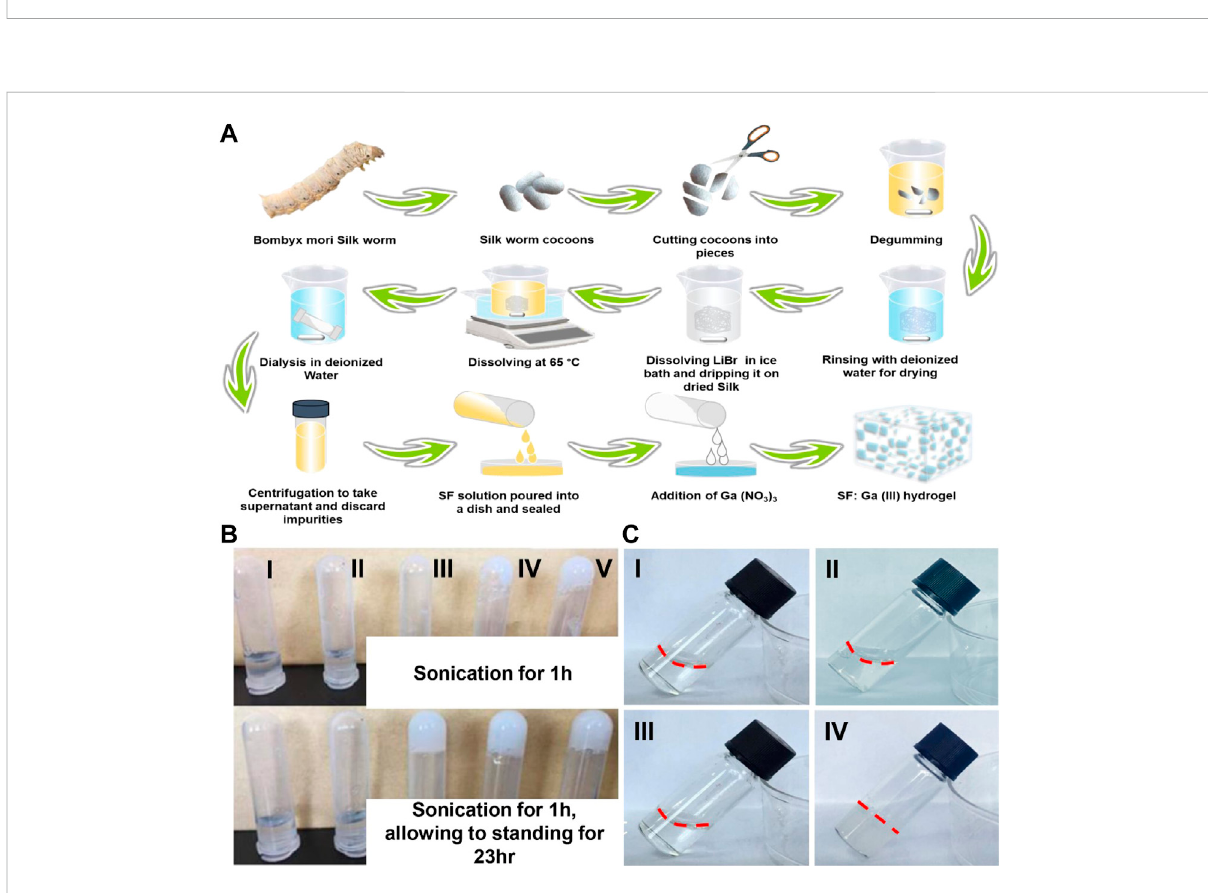
FIGURE 2 Synthesis of hydrogels. (A) Schematic illustration of the preparation of SF and SF: Ga (III) hydrogels, (B) Digital images of (I) SF: Ga (III) = 5000: 1 (w/w), (II) SF: Ga (III) = 2500: 1 (w/w), (III) SF: Ga (III) = 1000: 1 (w/w), (IV) SF: Ga (III) = 500: 1 (w/w) (SF/Ga) and (V) SF: Ga (III) = 250: 1 (w/w) hydrogels, (C) Digital image of SF solution (I, II) and SF: Ga (III) = 500: 1 (w/w) (SF/Ga) hydrogel (III, IV) before and after sonication and standing for 23